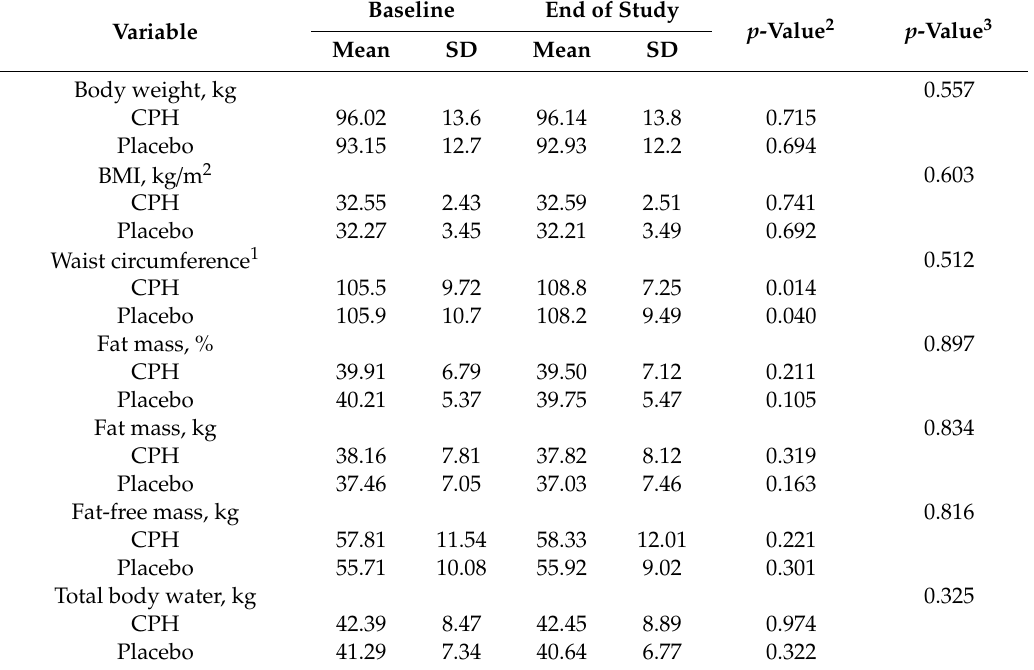
Table 3. Anthropometric measurements and results from the bioimpedance analysis (BIA) in the cod protein hydrolysate (CPH) group ( n = 15) and the placebo group ( n = 15) at baseline and end of study (8 weeks). Baseline End of Study p -Value 2 p -Value 3 Variable Mean SD Mean SD Body weight,